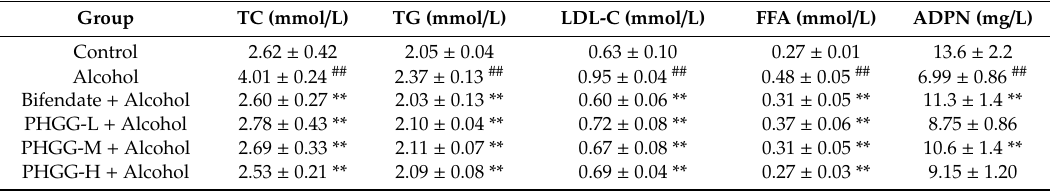
Table 3. E ff ect of partially hydrolyzed guar gum (PHGG) treatments on serum lipid levels and adiponectin